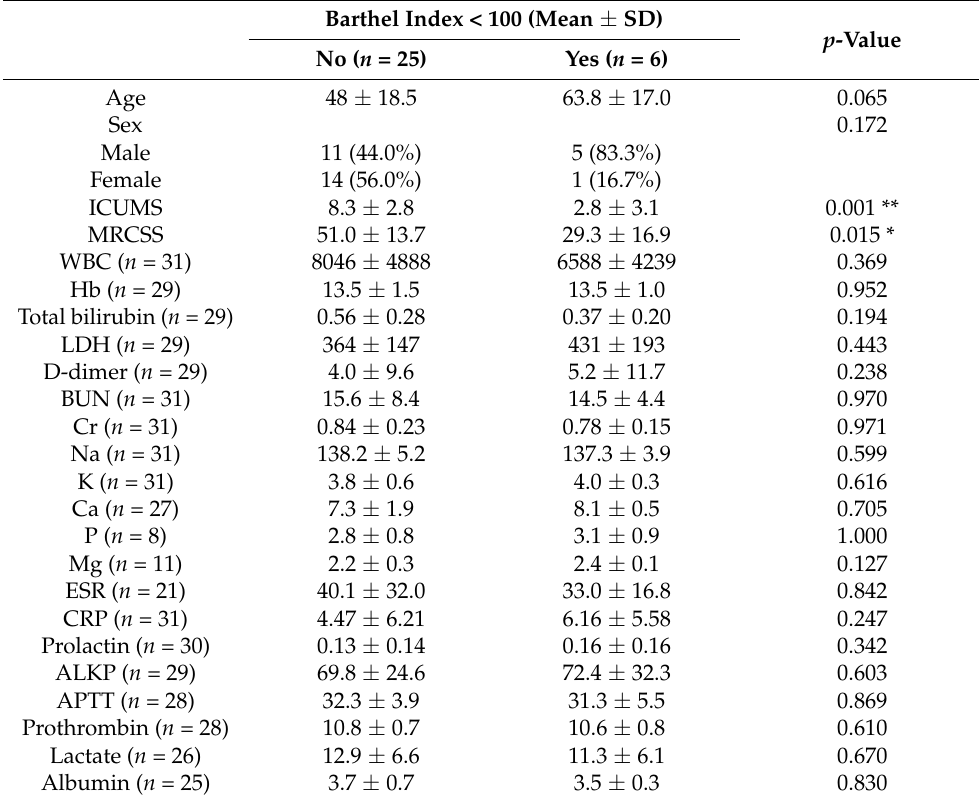
Table 2. The comparison of clinical characteristics and initial blood profiles between the groups based on Barthel index recorded three months after